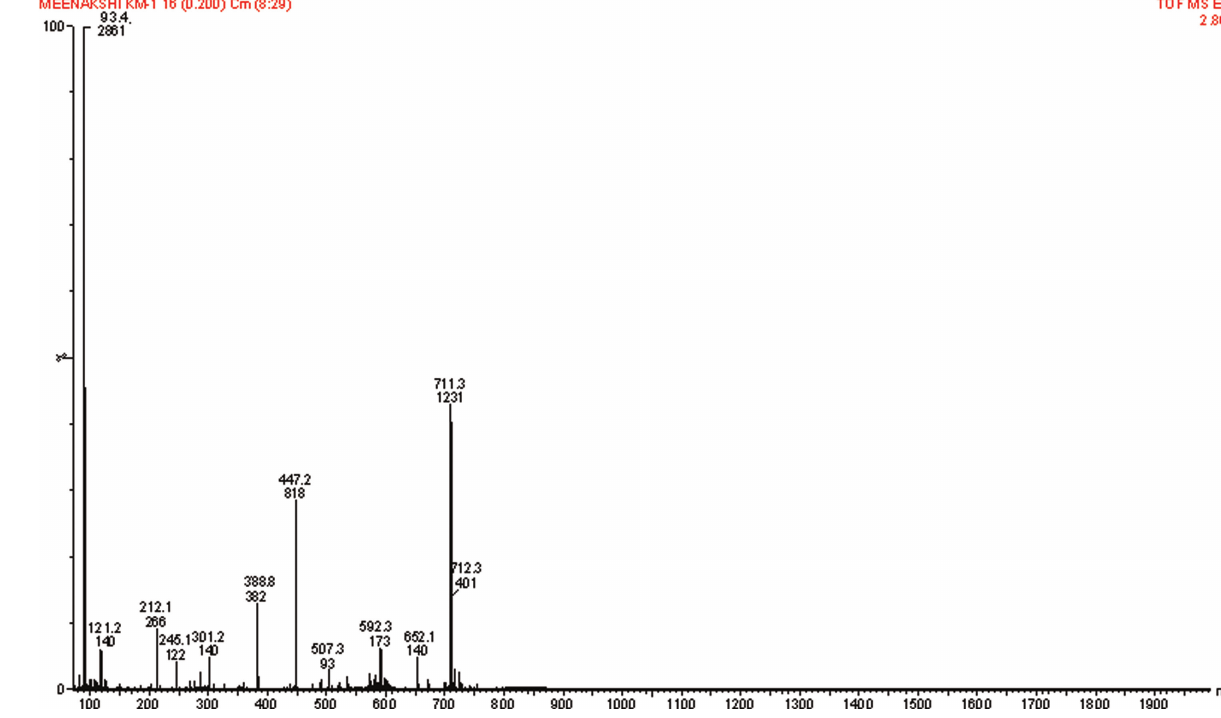
Al (pbox) (OPr i ) ] 1 2 2 2 2